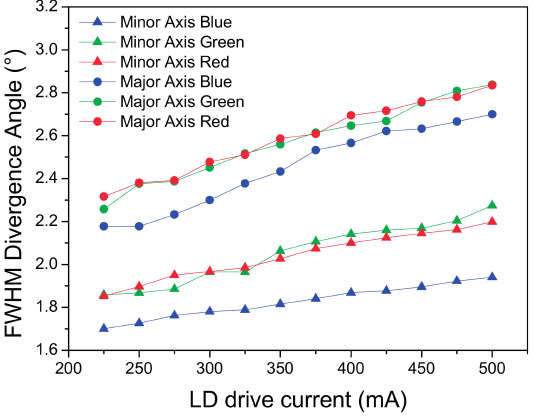
Figure 12. RGB FWHM divergence angle analysis for the transmission LARP setup on the major axis.